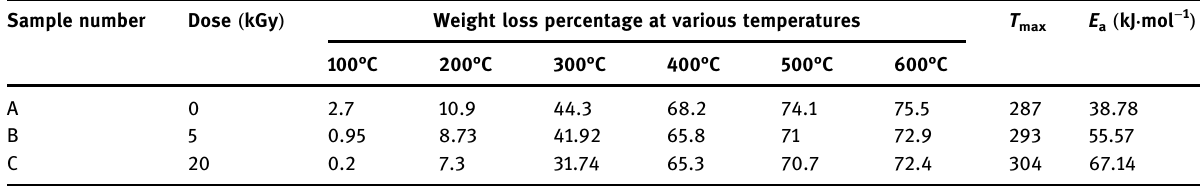
Table 2: Weight loss of samples A, B, and C at di ff erent temperatures Sample number Dose ( kGy ) Weight loss percentage at various